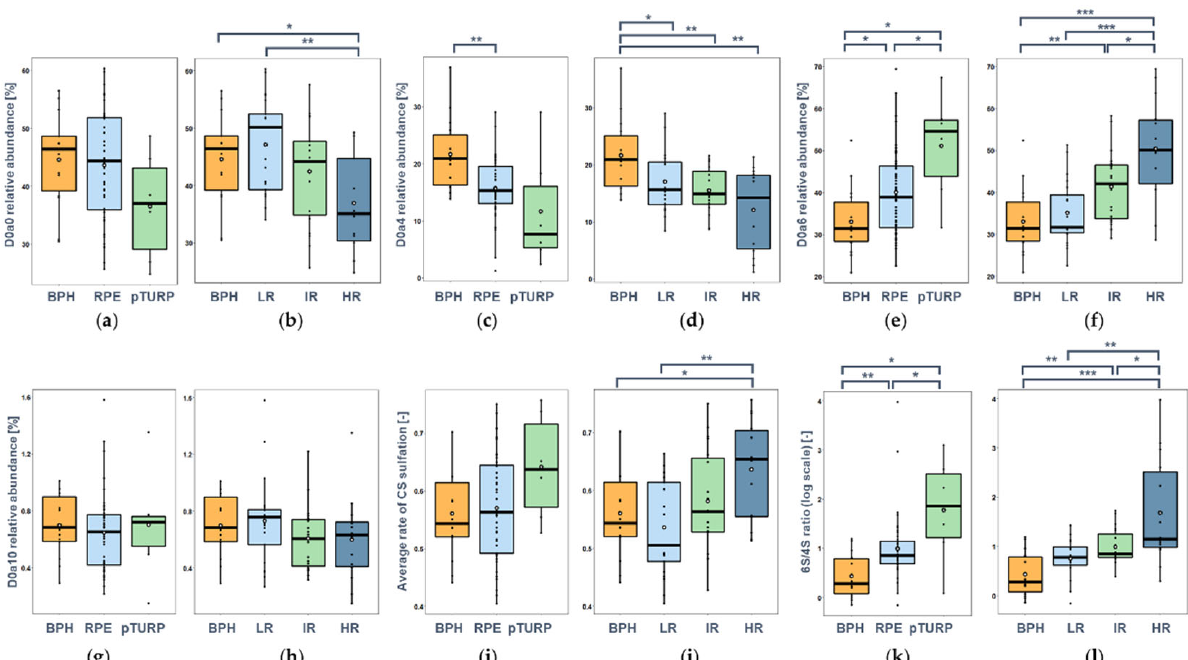
Figure 4. Relative abundance and sulfation characteristics of measured CS disaccharides as a function of the operation type and the risk stratification based on Gleason scores, respectively: ( a , b ) D0a0; ( c , d ) D0a4; ( e , f ) D0a6; ( g , h ) D0a10; ( i , j ) average rate of CS sulfation; ( k , l ) 6S/4S ratio. (*: p < 0.05, **: p < 0.01, ***: p < 0.001). See Figure 1 for resolving the GAG structure codes.